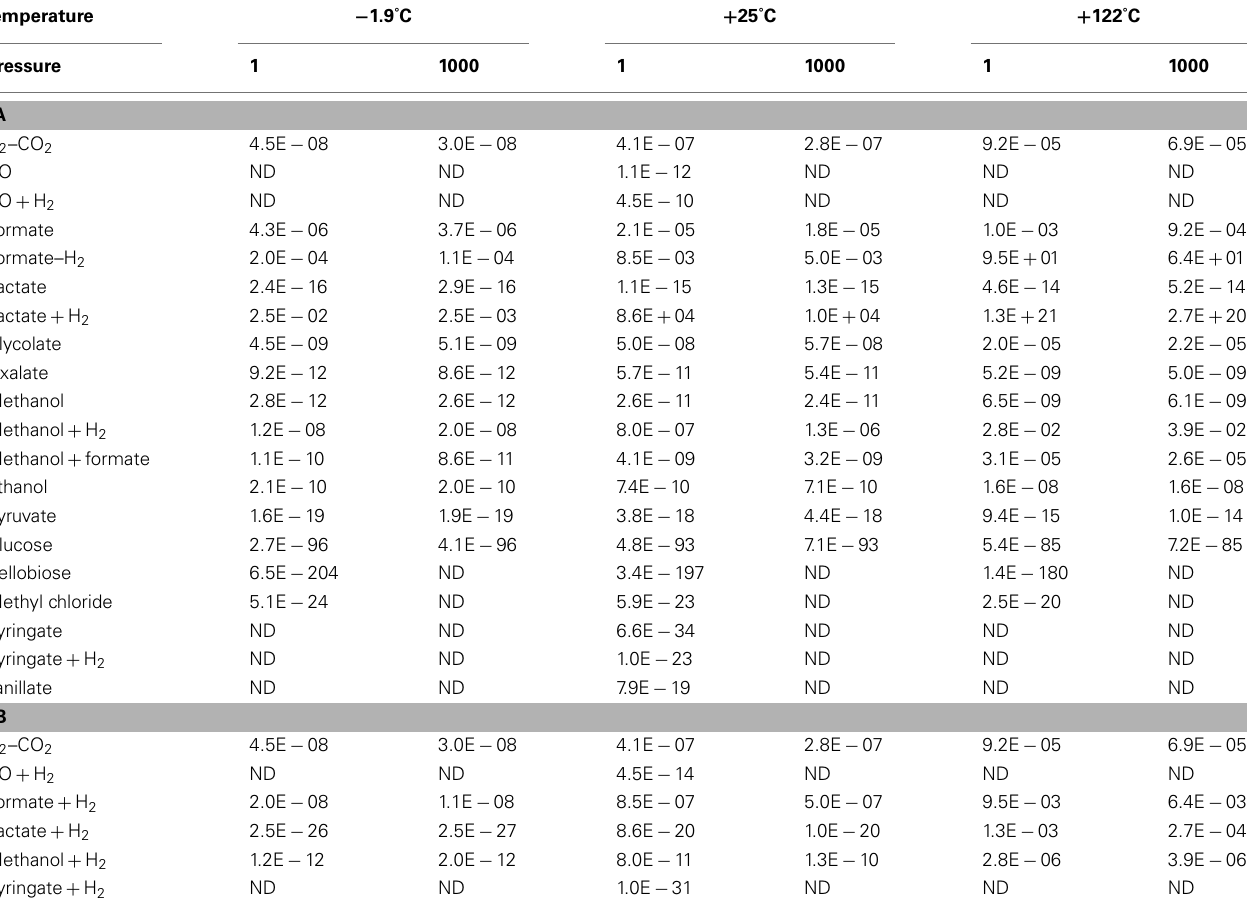
Table 5 |Thermodynamic threshold concentrations of widespread acetogenesis reactions at a wide range of temperatures and pressures, assuming a biological energy quantum of Δ G (cid:3) f = − 10kJmol - 1